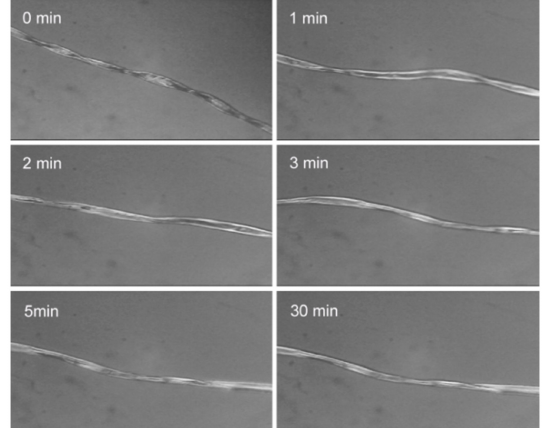
Figure 1. Swelling of cotton fibers by IL with time varying.